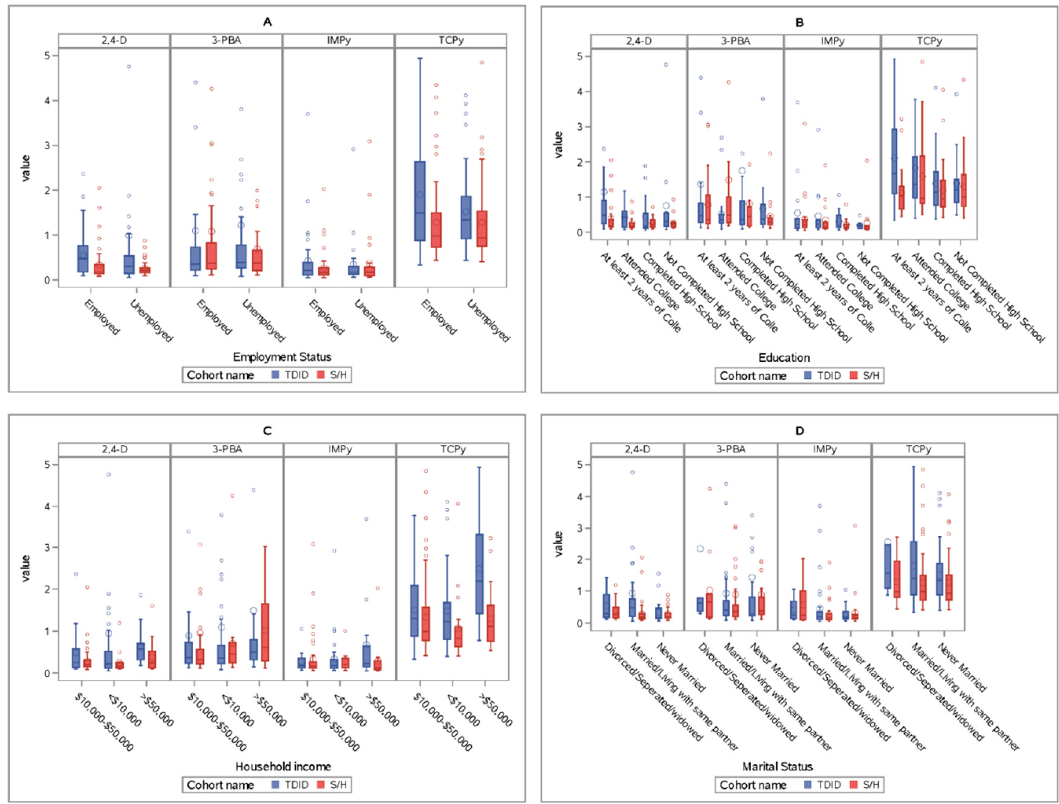
Figure 1. Comparison of concentrations of four metabolites of organophosphate, pyrethroid pesticides and 2,4-D herbicide by cohort .